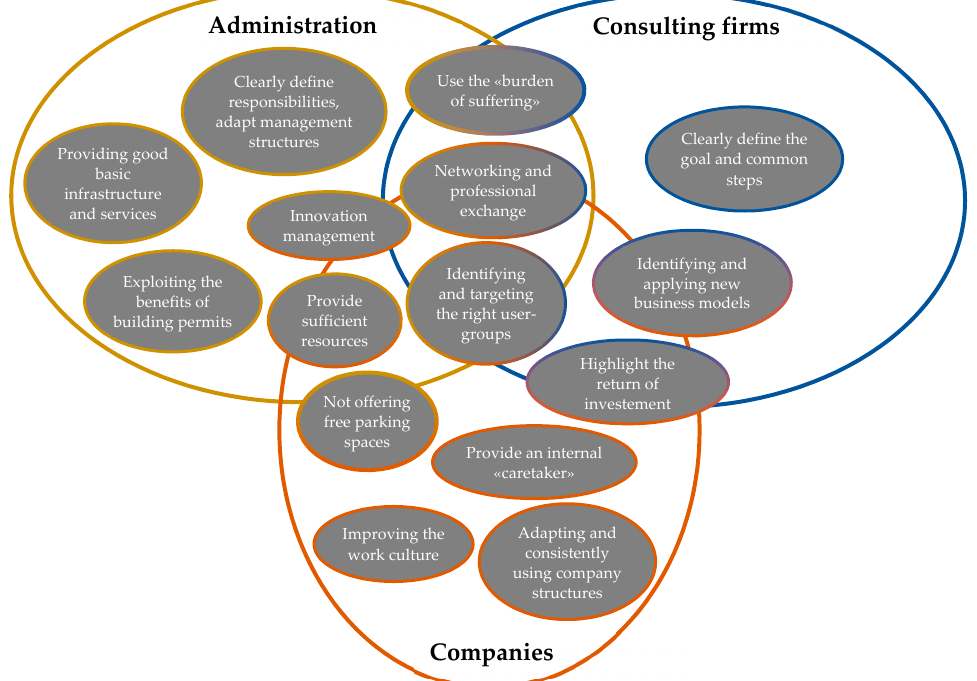
Figure 4. Overview of recommendations in implementing mobility management in administrations and companies and the role of consulting firms.